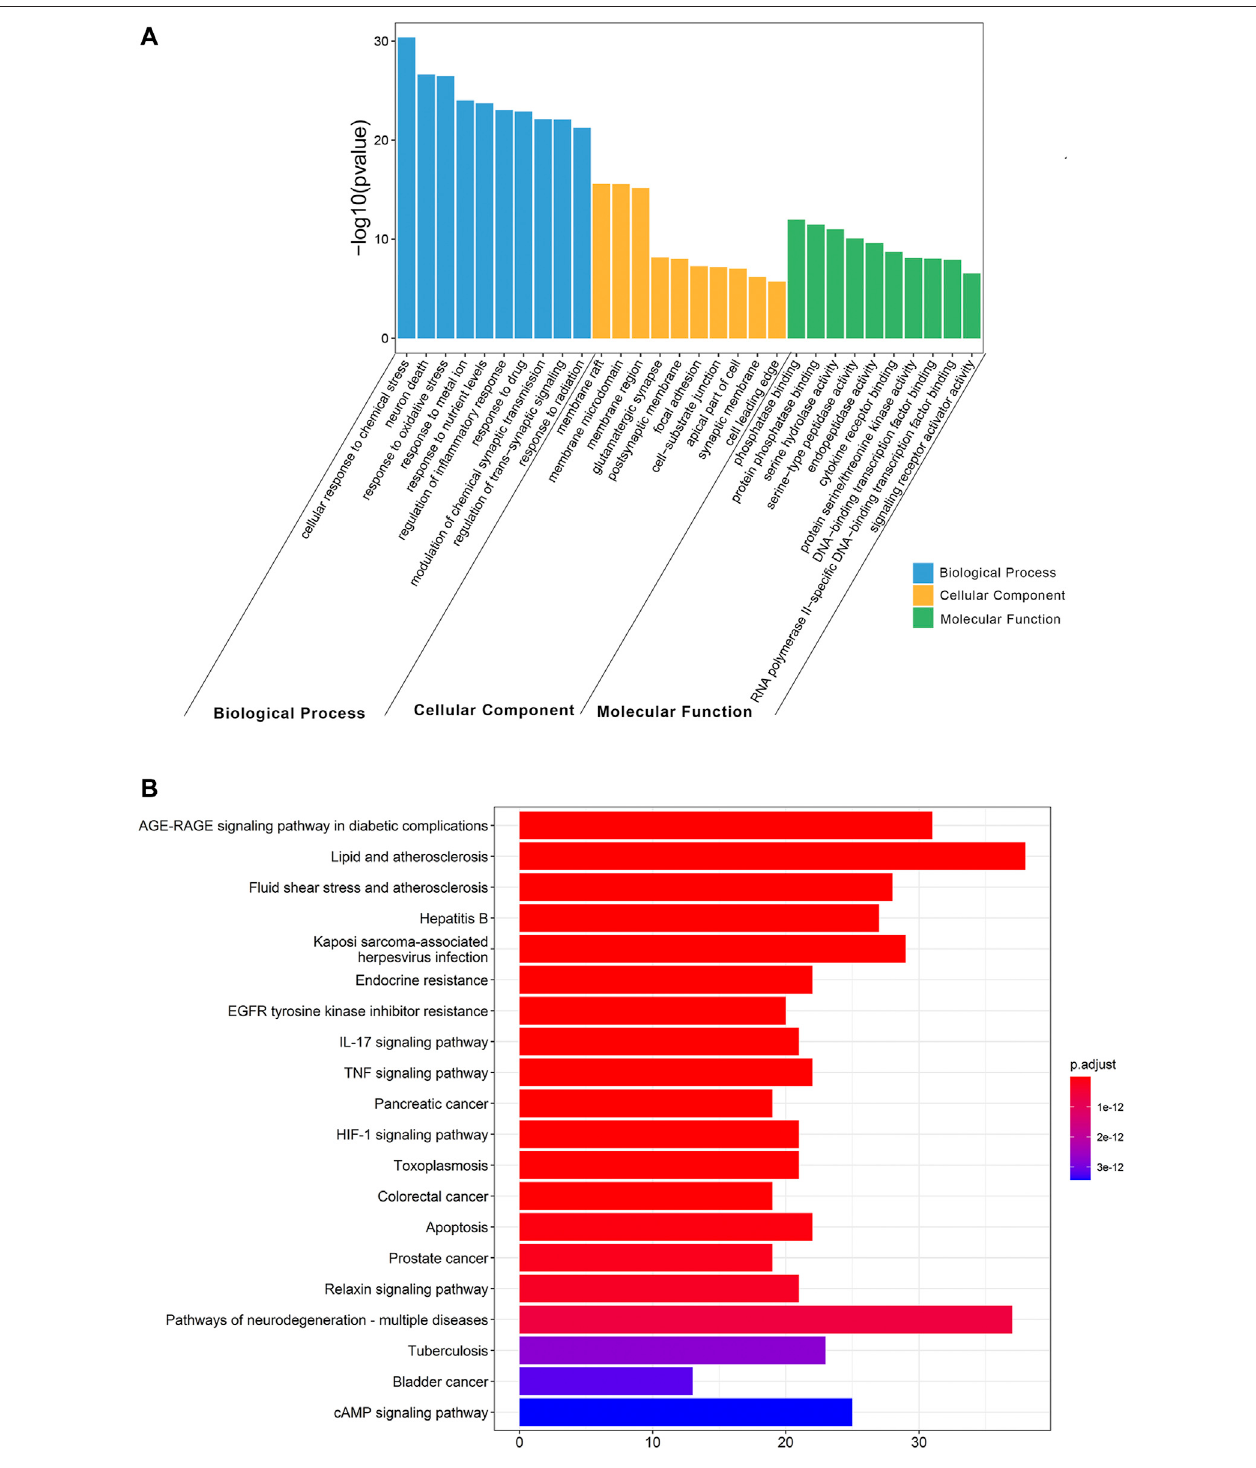
FIGURE4| GeneOntology(GO)andKyotoEncyclopediaofGenesandGenomes(KEGG)pathwayenrichmentanalysis. (A) GOfunctionalenrichmentanalysis. (B) KEGG pathway enrichment analysis.